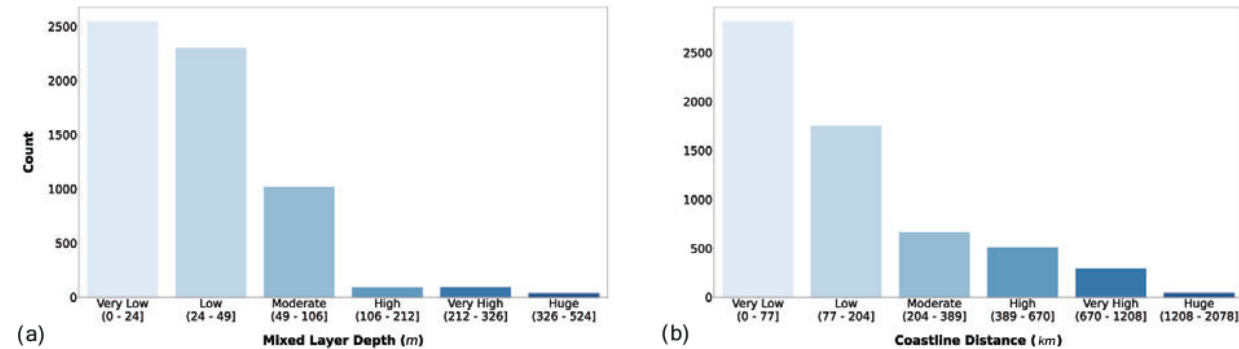
Figure 4. (a) MLD (m) and coastal-distance (km) magnitude. The bar color intensity reflects the magnitude of the class values.